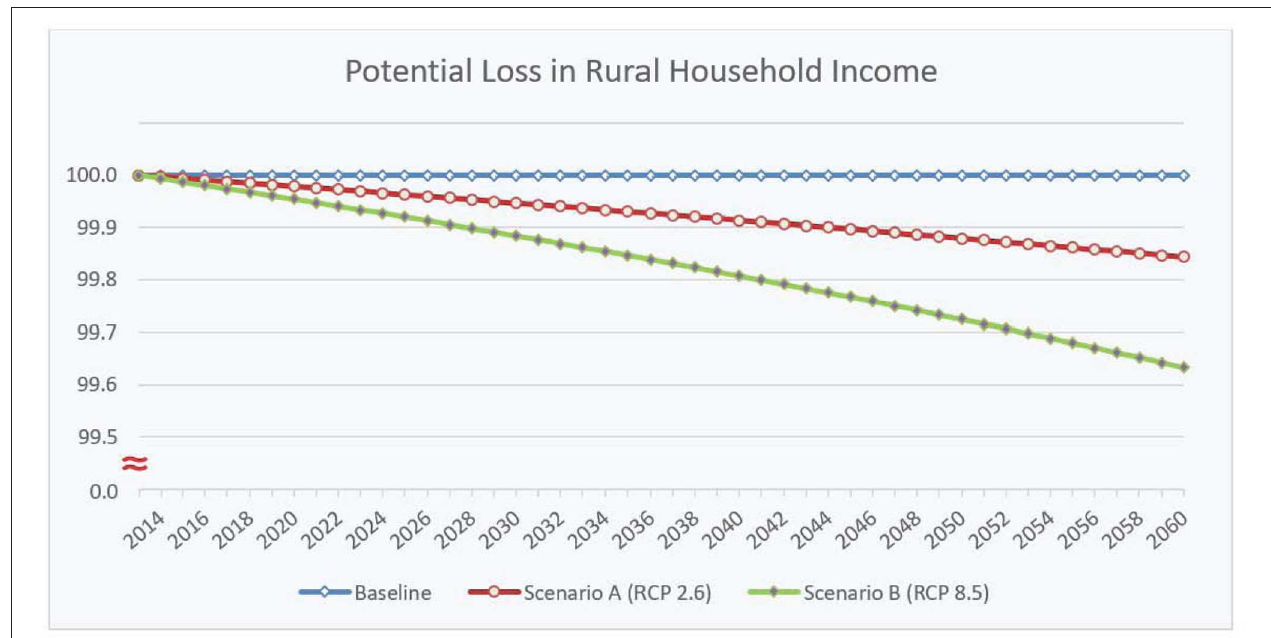
FIGURE 4 | Projection of loss in rural household income by scenario. Income level in base year is normalized to